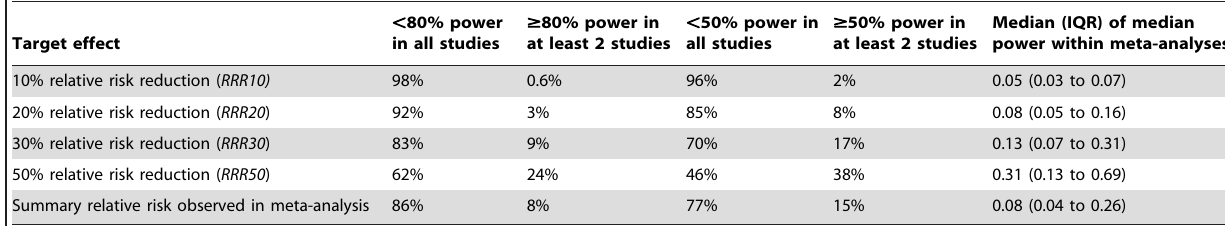
Table 1. Percentages of 14,886 meta-analyses including no studies adequately powered to detect a target effect or including at least two adequately powered studies, where adequate power is defined as 80% or 50% in turn; and summary of median power within each